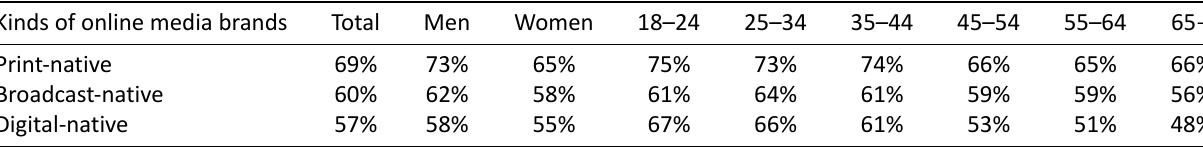
Table 1. Kinds of brands used for checking the news online in the last week (N = 2005, January 17–February 21, 2019). Kinds of online media